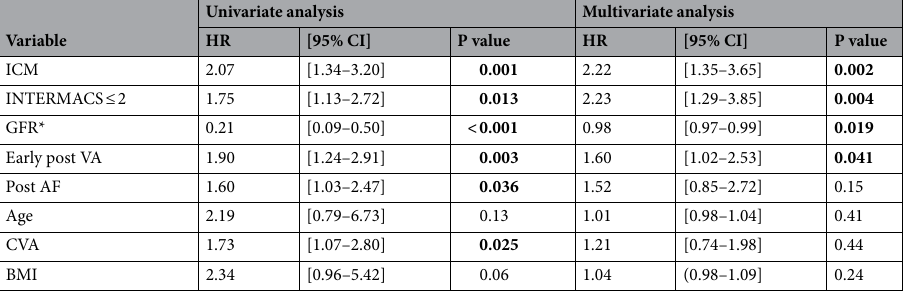
Table 3. Univariate and multivariate analysis for mortality in patients with DT LVAD. P values presented in bold are statistically significant (<0.05). *Per unit change, AF atrial fibrillation, CI confidence interval, CVA cerebrovascular accident, DT destination therapy, GFR glomerular filtration rate, HR hazard ratio, ICM ischemic cardiomyopathy, INTERMACS Interagency Registry for Mechanically Assisted Circulatory Support, LVAD left ventricular assist device, VA ventricular